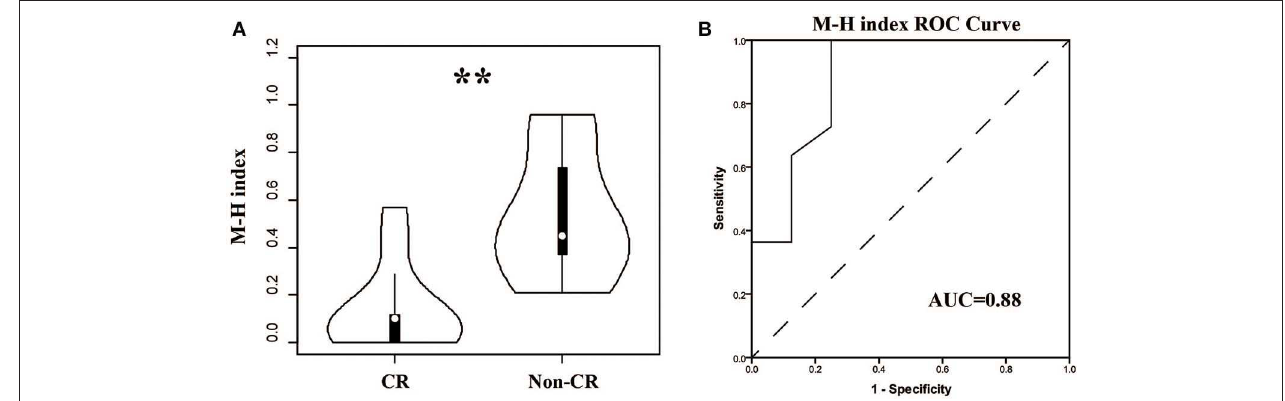
FIGURE 6 | Comparison of the similarities between pre- and post-therapy in CR and non-CR patients after 6-months therapy. (A) The Morisita-Horn similarity (MH) index in CR group and non-CR group. (B) ROC analysis to separate the two groups. ** P <